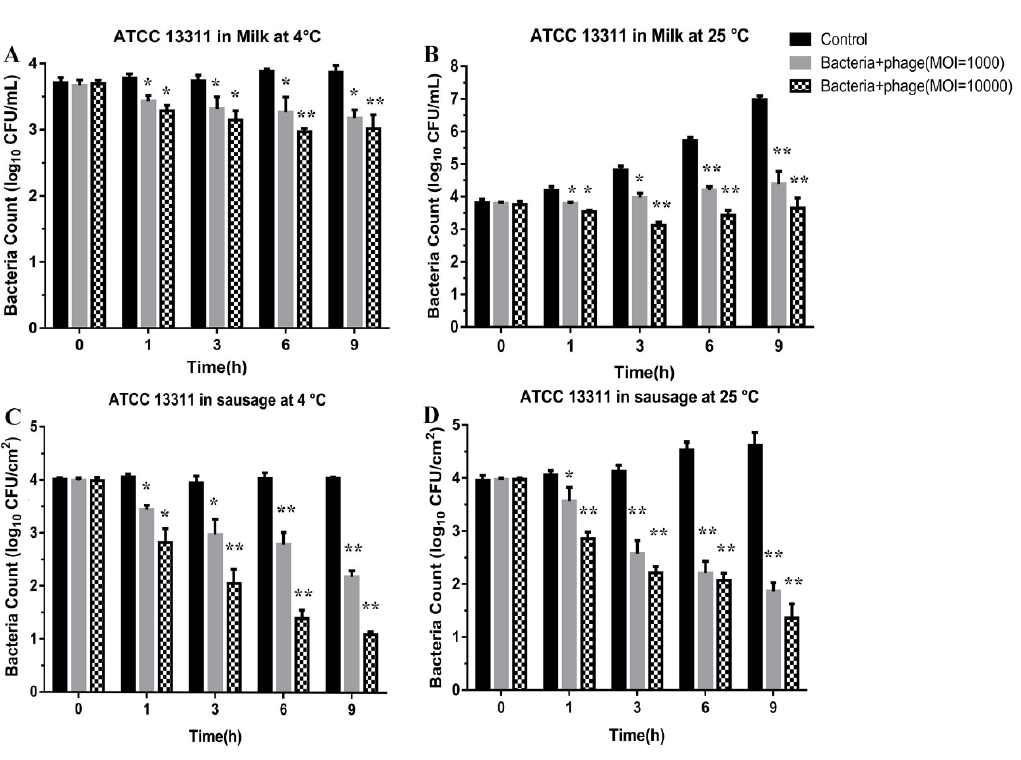
Figure 5. Effectiveness of phage LPST153 in reducing S. Typhimurium ATCC 13311 in food matrices. Effect of phage LPST153 on growth of S . Typhimurium ATCC 13311 in the milk incubated at ( A ) 4 °C and ( B ) 25 °C and in sausage incubated at ( C ) 4 °C and ( D ) 25 °C. Values represent mean with standard deviation of three determinations. ** Significant at p < 0.01; * Significant at p < 0.05.